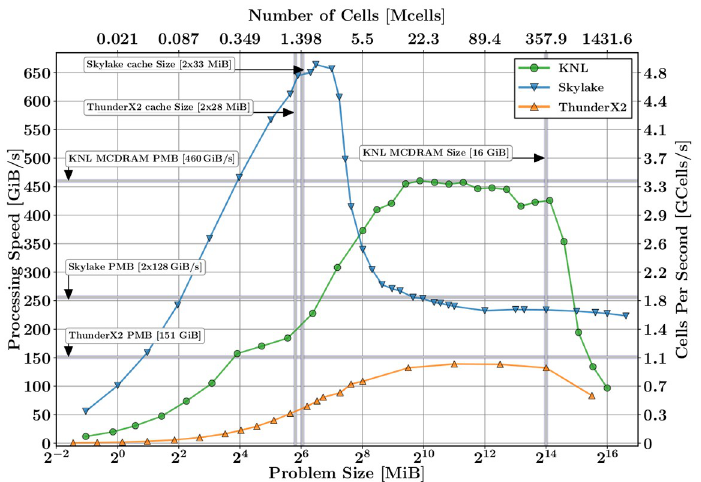
Fig 4. UGRFDTD performance on single nodes of Marconi, MareNostrum, and Wombat platforms. Memory sizes are delimited with vertical lines, and PMB with horizontal lines.